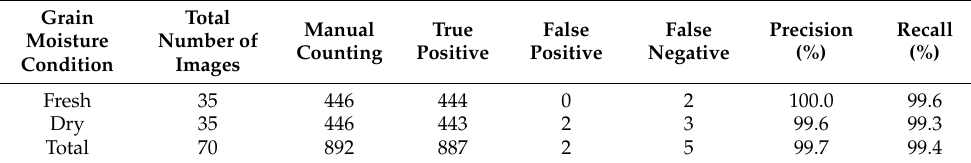
Table 7. The detection results of grains with different dry